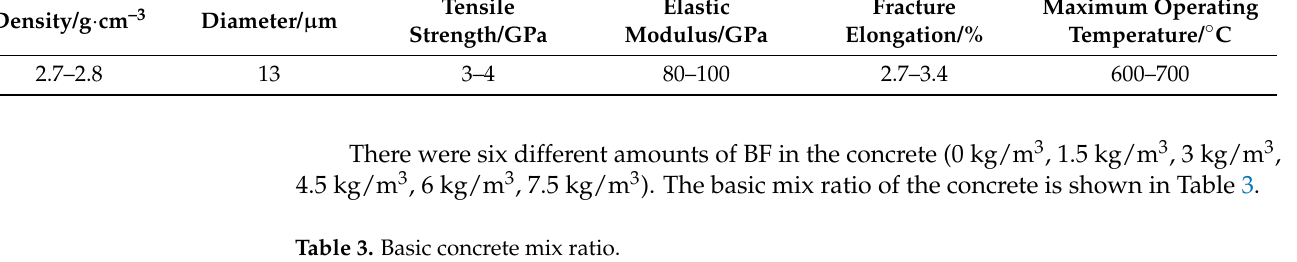
Table 3. Basic concrete mix